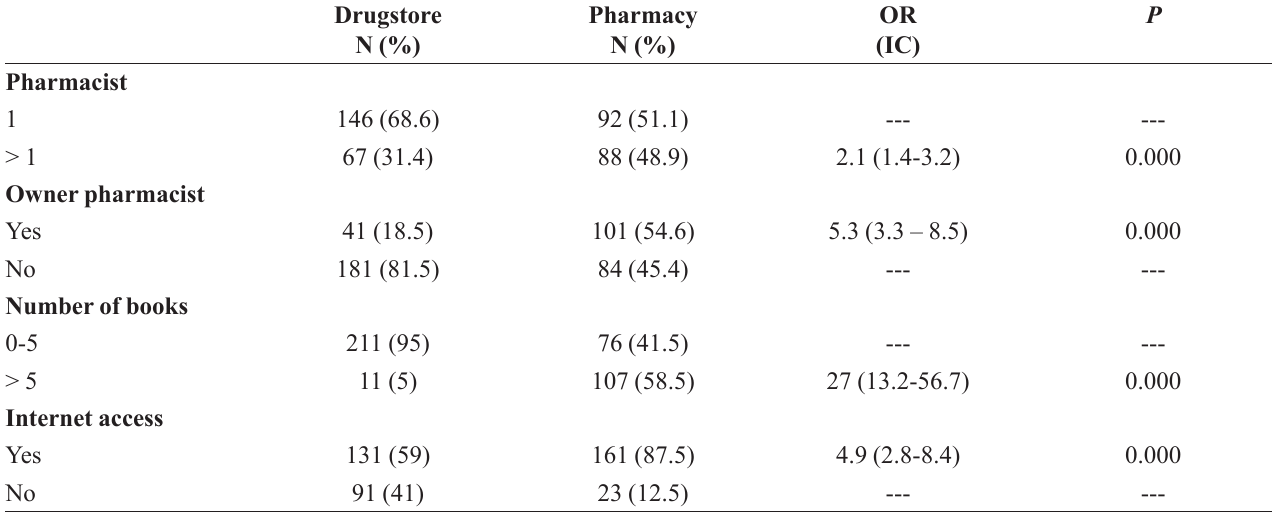
TABLE I – Relationship between drugstores and pharmacies respecting to number of pharmacists, ownership of establishment and information sources